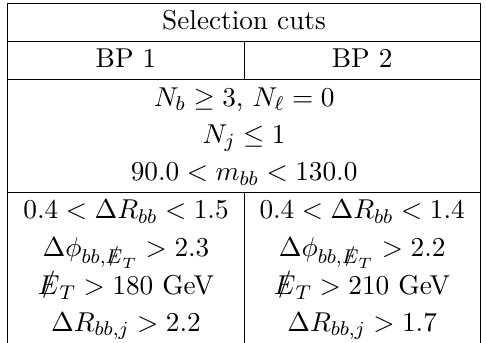
Table 16. The selection cuts optimised for the b-tag b ¯ b + /E BPs Background yield at 3 ab − 1 after all cuts susy Backgrounds SM Backgrounds